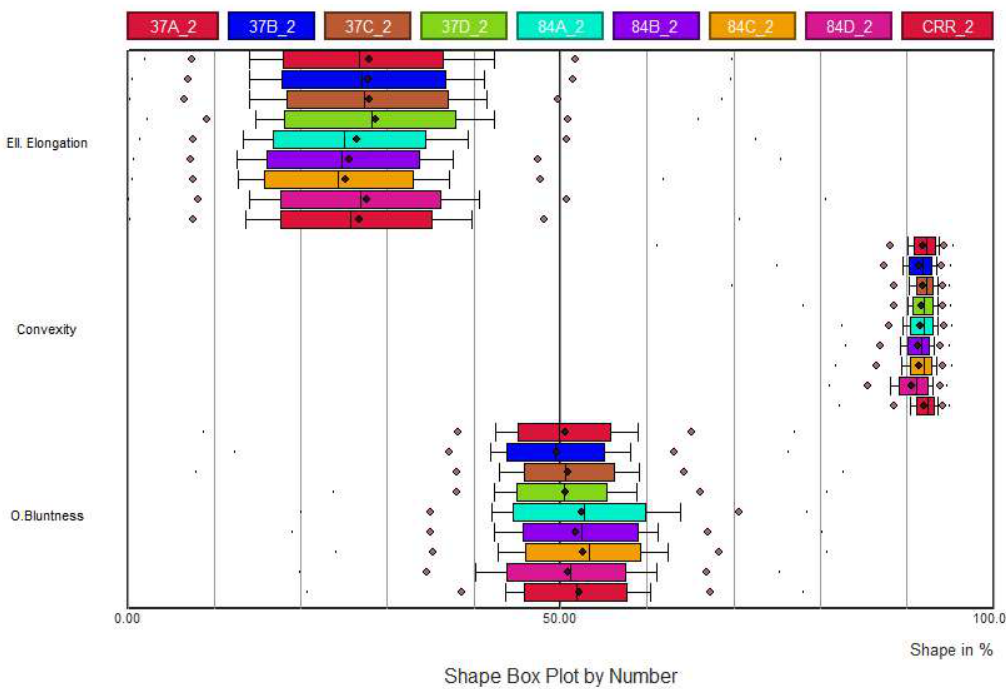
Figure A2. Shape analysis of particles (2–4 mm) (84 refers to raw materials: 84A, 84B, 84C and 84D refer to M84Af, M84Bf, M84Cf and M84Df, respectively; 37 refers to recycled materials after treatment: 37A, 37B, 37C and 37D refer to recycled materials after treatment M37Af, M37Bf, M37Cf and M37Df, respectively; CRR refers to recycled materials after compaction: CRR11f).